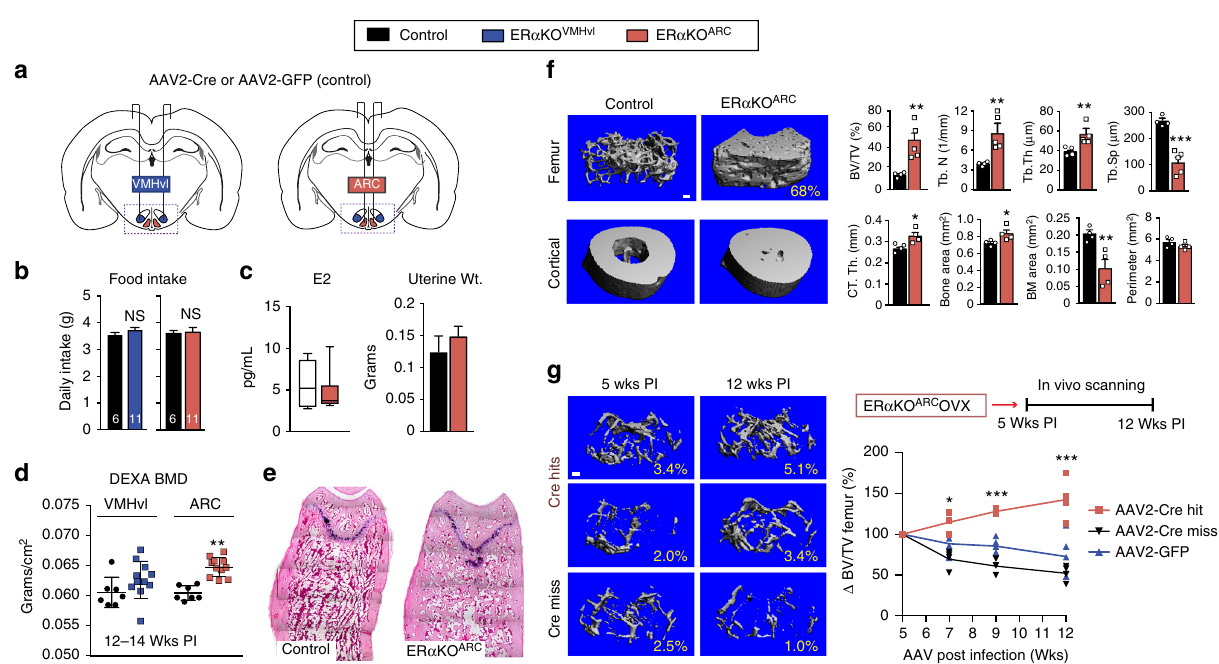
Fig. 4 Bone volume in intact and OVX female mice after acute loss of ER α in ARC. a Schematic of stereotaxic delivery of AAV2-GFP or AAV2-Cre-GFP to 16-week-old Esr1 fl / fl females to either the VMHvl or ARC regions to delete ER α 5-week postinfection (PI). b Food intake for AAV2-GFP (black bars), AAV2- Cre-VMHvl (blue bars) and AAV2-Cre-ARC (red bars). c LC – MS/MS plasma E2 and uterine weight for control ( n = 6, open box) and for ER α KO ARC ( n = 9 – 11, red box) (center line = median; bounds are minimum to maximum). d Scatter plot of BMD for controls, ER α KO VMHvl , and ER α KO ARC females. e Representative images of distal femur (H&E) in control and ER α KO ARC females. f μ CT images with morphometric properties of distal femur for controls ( n = 4) and ER α KO ARC ( n = 5) and tibio- fi bular joint in control ( n = 4) and ER α KO ARC ( n = 4) females. Scale bar = 100 μ m. g Representative μ CT images of distal femur in OVX females 5- and 12-week postinfection, showing AAV2-Cre hit to ARC (Cre-Hits, Red line), AAV2-Cre miss to ARC (Cre-Miss, black line and AAV2-GFP to ARC (blue line)). Schematic of time line for in vivo bone imaging from 5- to 12-week PI, with graph showing percent change in volumetric bone normalized to 5 week PI. Cre-Hits ( n = 5), Cre-Miss ( n = 4), and GFP ( n = 5), AAV2-Cre Hit versus GFP or Miss ( F 2,40 = 56.9, p